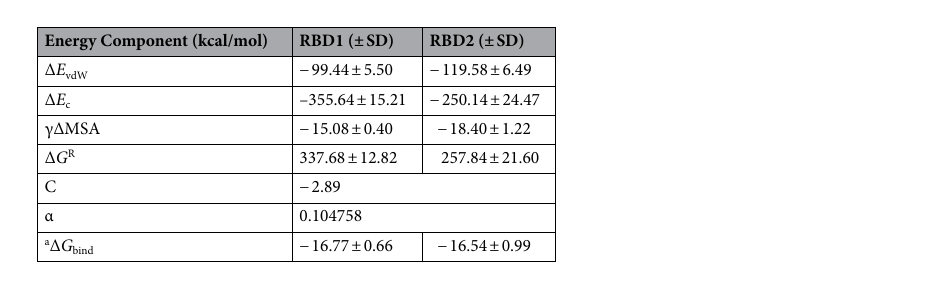
Table 1. Binding free energy (kcal/mol) of MSI1 RBD1/2:GUAGU complexes calculated by the solvated interaction energy method (n = 200, SD = standard deviation).